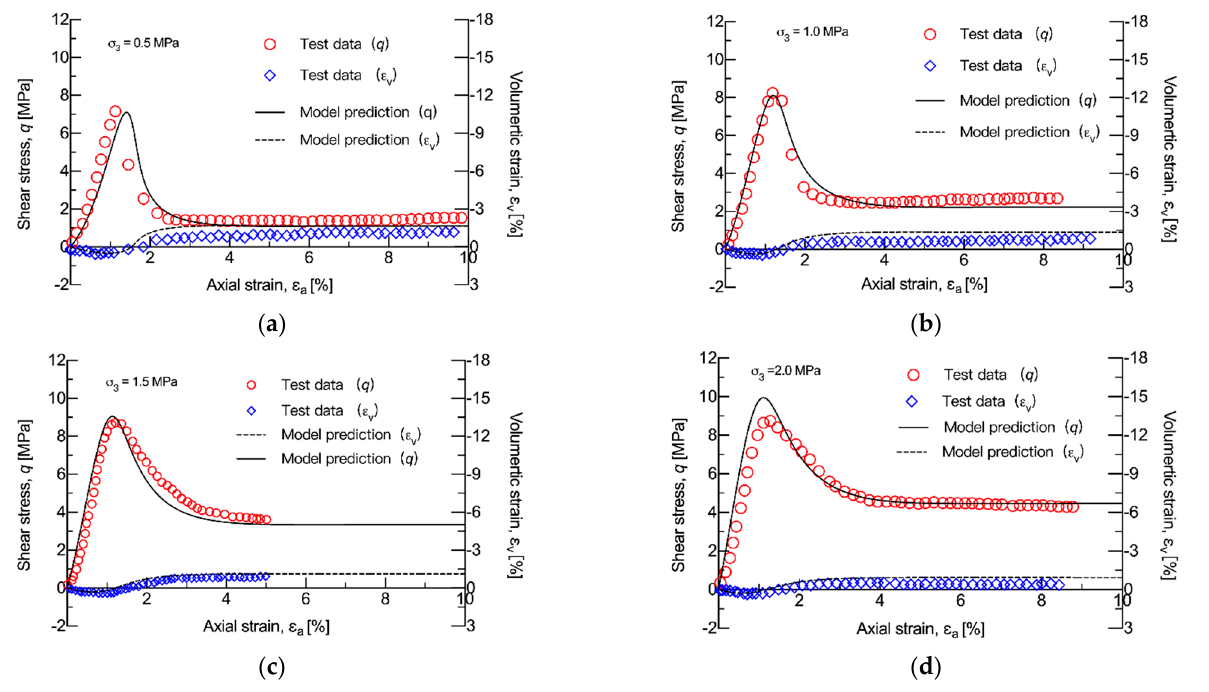
Figure 6. Experimental data and model predictions: ( a ) 𝜎 (cid:2871) = 0.5 MPa; ( b ) 𝜎 (cid:2871) = 1.0 MPa; ( c ) 𝜎 (cid:2871) = 1.5 MPa; ( d ) 𝜎 (cid:2871) = 2.0 MPa).